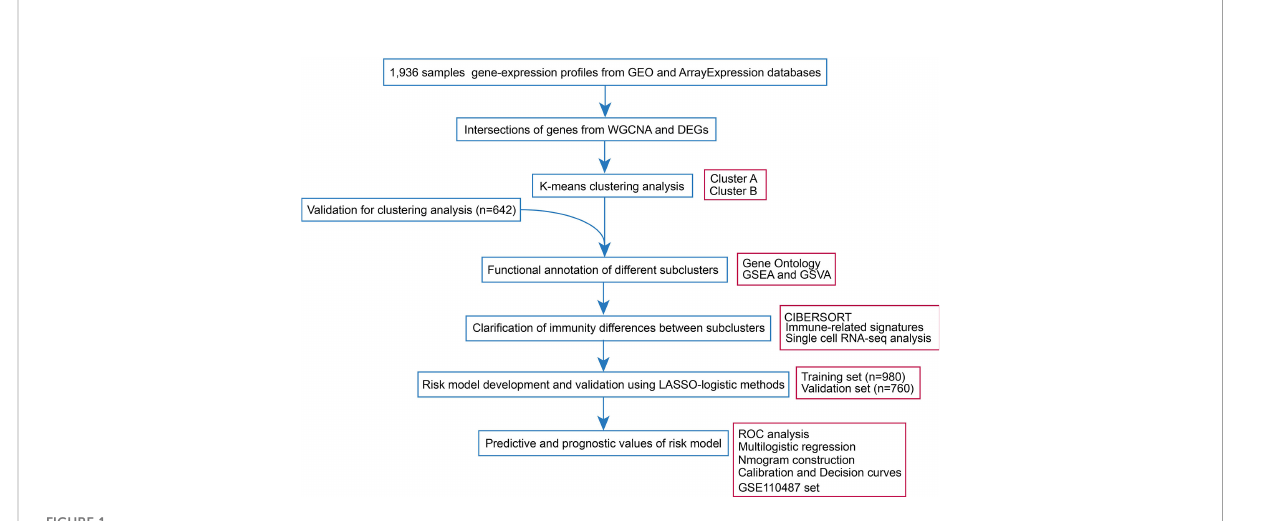
FIGURE 1 Work fl ow of the present